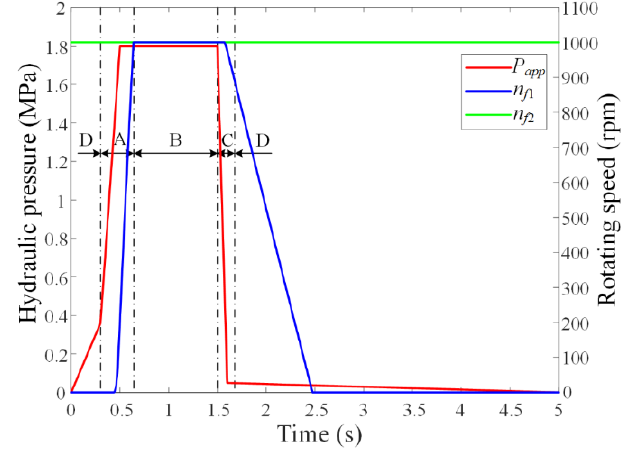
Figure 4. Variations of the hydraulic pressure and rotating speeds.